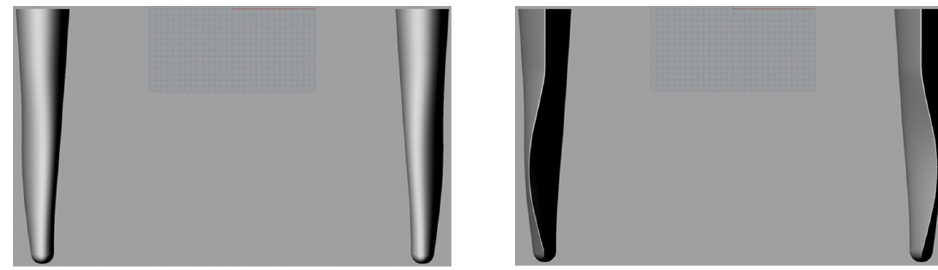
Figure 21. The 3-D modeling of the asymmetry-type rudder (( left ): front view, ( right ): rear view).